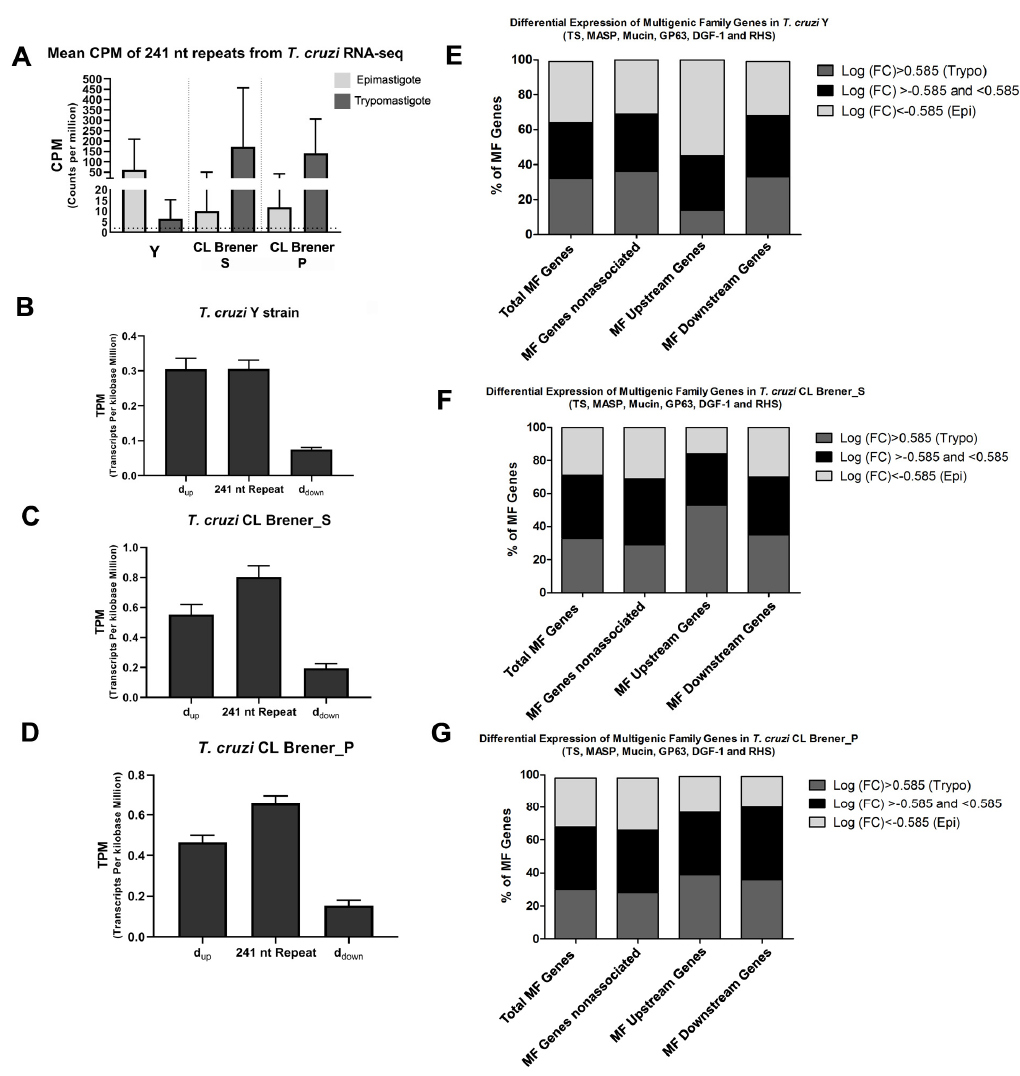
Figure 5. RNA-seq analysis from Y and CL Brener strains of T. cruzi . After RNA-seq alignment with reference genomes (Y and CL Brener strains), the coverage and expression profile were obtained from 241 nt repeats and surrounding regions. ( A ) CPM values from 241 nt repeats in epimastigotes (light gray) and trypomastigotes (dark gray) (CL Brener and Y strain). The dashed line indicates the cut-off (2). ( B – D ) TPM values from transcripts aligned in the 241 nt repeat, d up and d down segments of CL Brener_S ( B ), CL Brener_P ( C ) and Y strain ( D ). ( E – G ) Gene expression profile of multigenic families associated and nonassociated with the 241 nt repeat. The Log2(FC) values of the trypomastigote/epimastigote ratios were calculated, and a FC of 1.5 x was chosen as the cut-off. A Log2(FC) > 0.585 indicates genes upregulated in trypomastigotes (dark gray), a log2(FC) < − 0.585 indicates genes upregulated in epimastigotes (light gray) and a log2(FC) between − 0.585 and 0.585 indicates nondifferential expression (black). Abbreviations: CPM-counts per million; TPM-transcripts per million, FC-fold change, TS-trans-sialidase, MASP-mucin-associated surface protein, DGF-1- dispersed gene family, RHS-retrotransposon hot spot and MF-multigenic family.